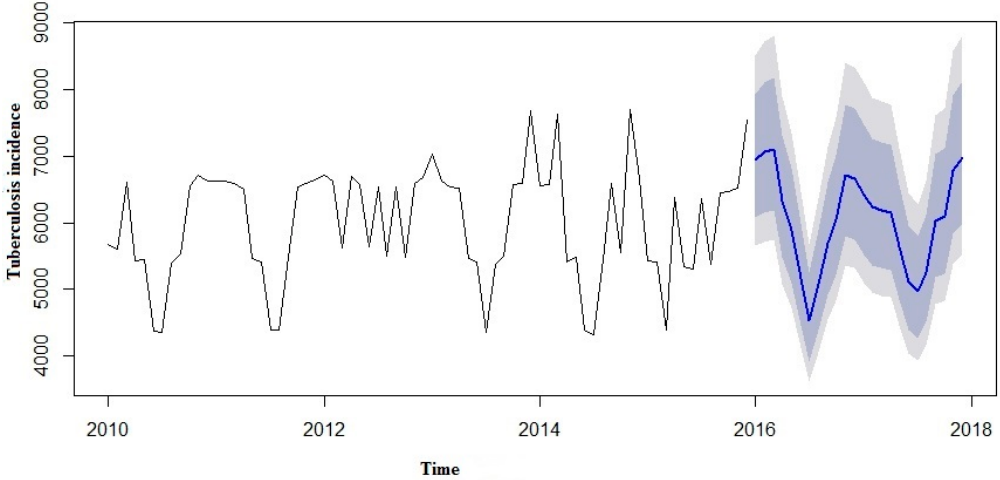
Figure 7. Forecast from SARIMA model applied to TB case prevalence.